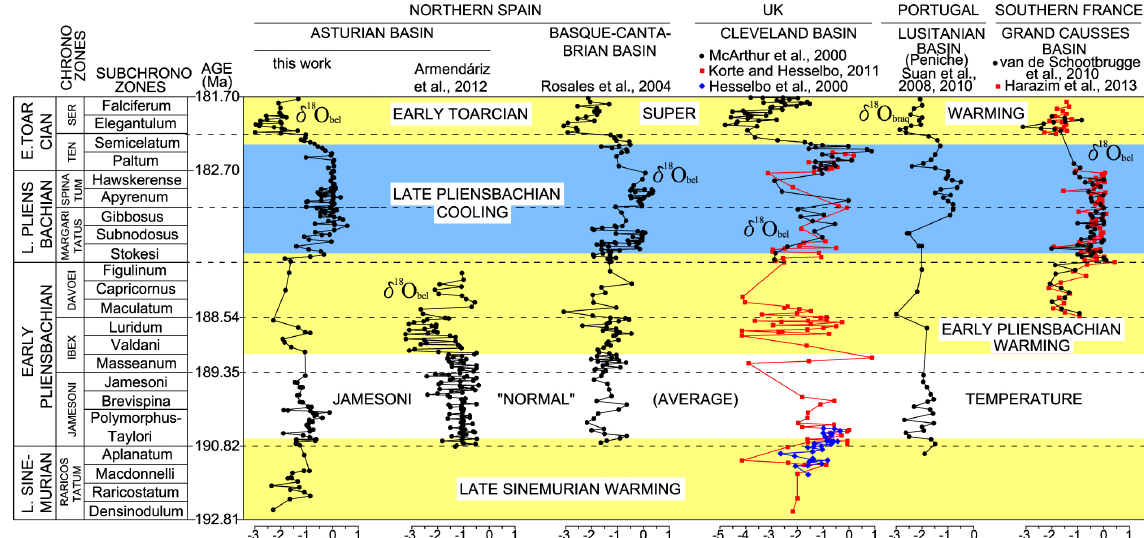
Figure 8. Correlation chart of the belemnite calcite-based δ 18 O sketched curves obtained in different areas of Western Europe. Several isotopic events along the latest Sinemurian, Pliensbachian and Early Toarcian can be recognized. The earliest event is a δ 18 O negative excursion corresponding to the Late Sinemurian Warming. After an interval of “normal” δ 18 O values developed in most of the Jamesoni Chronozone and the earliest part of the Ibex Chronozone, another δ 18 O negative excursion was developed in the Ibex, Davoei and earliest Margaritatus chronozones, representing the Early Pliensbachian Warming interval. A main δ 18 O positive excursion is recorded at the Late Pliensbachian and the earliest Toarcian in all the correlated localities, representing the important Late Pliensbachian Cooling interval. Another prominent δ 18 O negative shift is recorded in the Early Toarcian. Values are progressively more negative in the Tenuicostatum Chronozone and suddenly decrease around the Tenuicostatum–Serpentinum zonal boundary, delineating the Early Toarcian δ 18 O negative excursion which represents the Early Toarcian (super)Warming interval. δ 18 O bel values in PDB. Ages (Ma) after Ogg and Hinnov